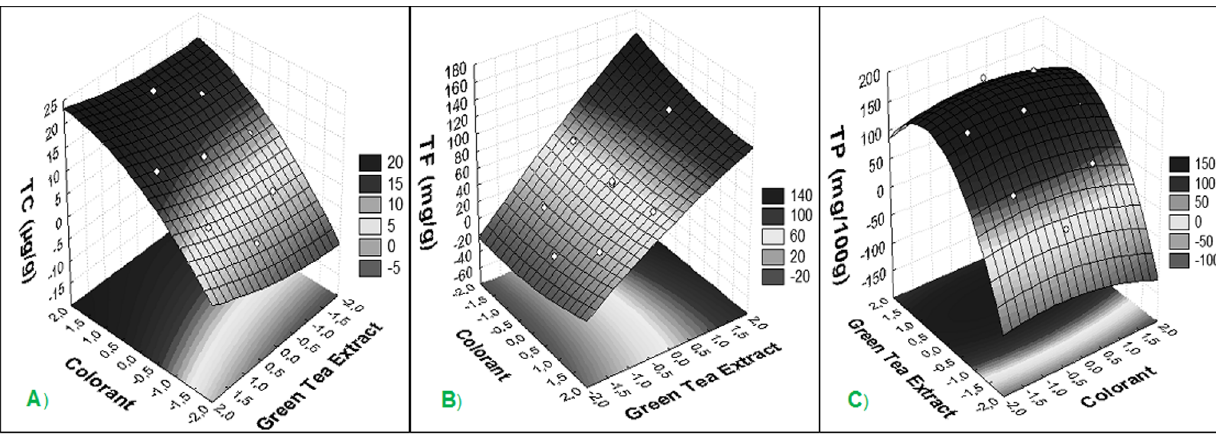
Figure 4. The response surface plot demonstrating the effect of incorporated additives to illustrate the effect of the increased factor on TP (mg/100 g), TF (mg/g) and TC ( m g/g) film preparation after 45 days of butter storage.